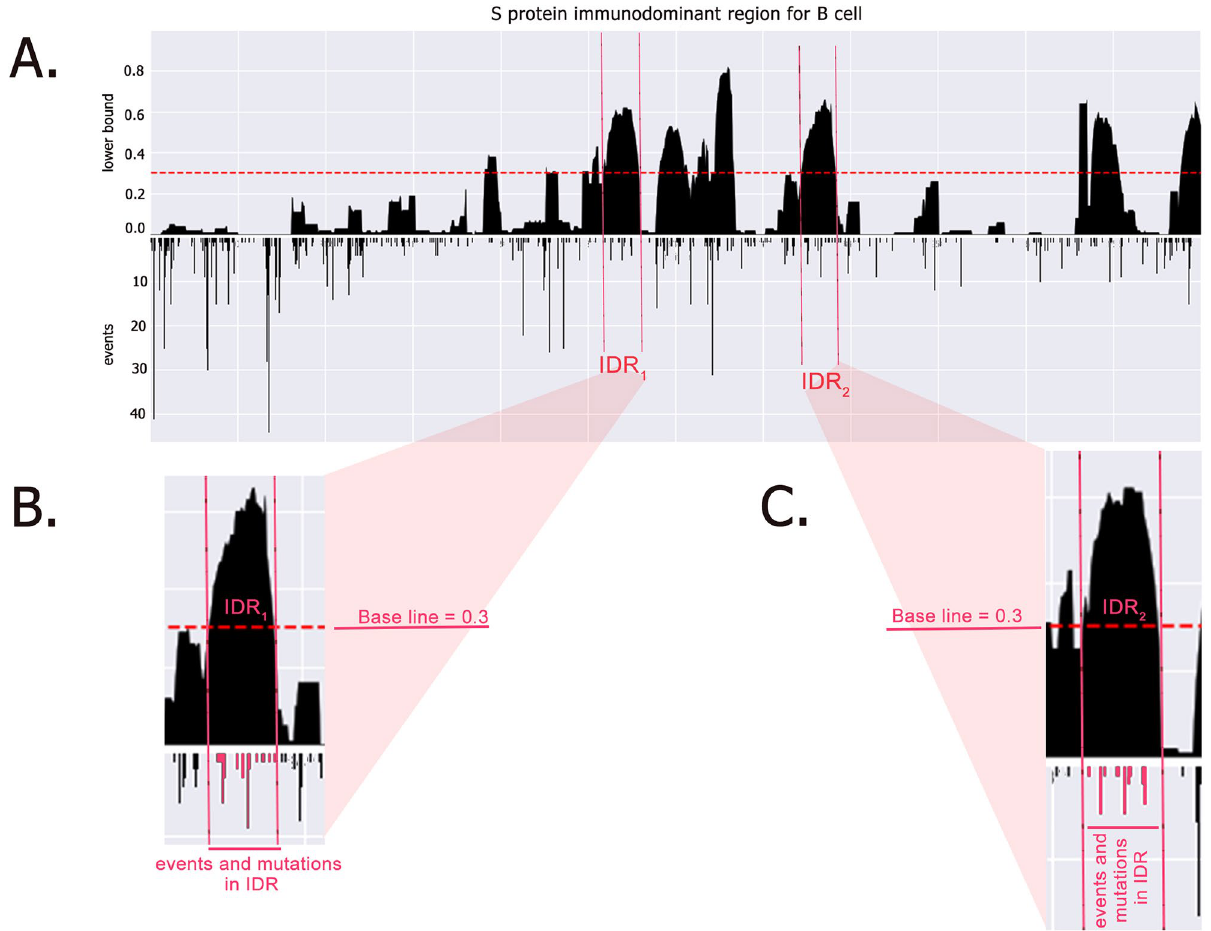
Figure 4. Example of IDRs of S protein for B cell response and events in their IDRs. In panel ( A ), two examples of IDRs (panel B , C ) are magnified and events in their site (vertical bars) are shown. This is a schematic view